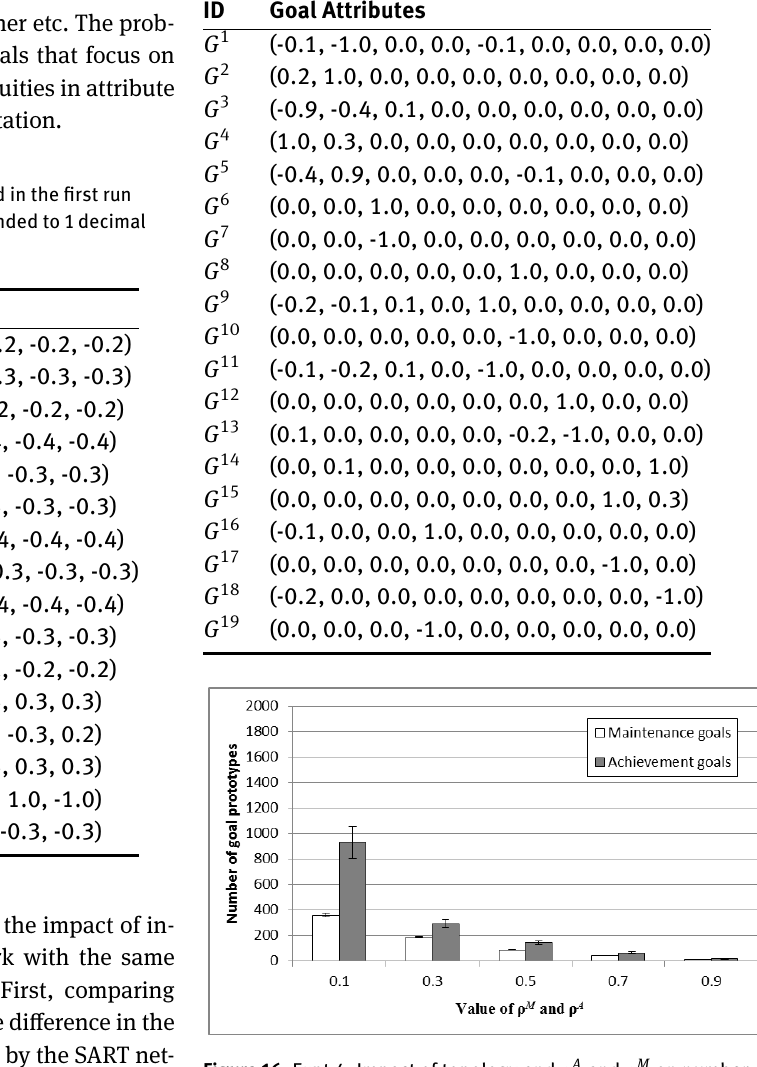
Figure 16: Expt 4: Impact of topology and ρ A and ρ M on number of on number of achievement (grey) and maintenance goals